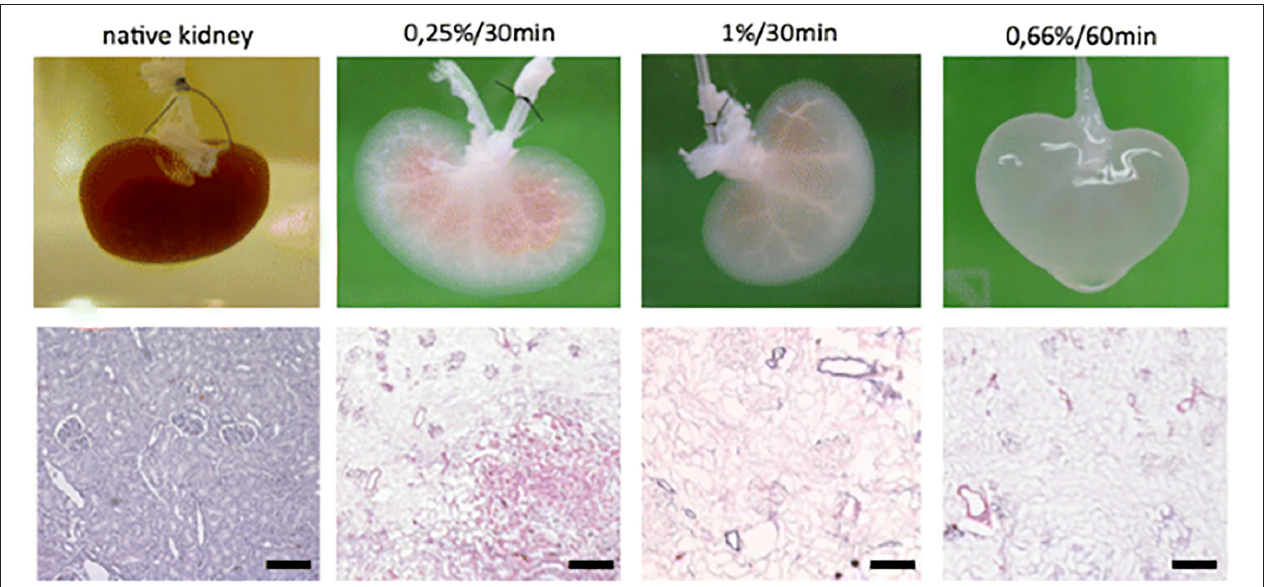
FIGURE 3 | Macroscopic and histologic investigation of kidney decellularization efficacy of different SDS concentration/perfusion time combinations. Reprinted Schmitt et al. ( 100).